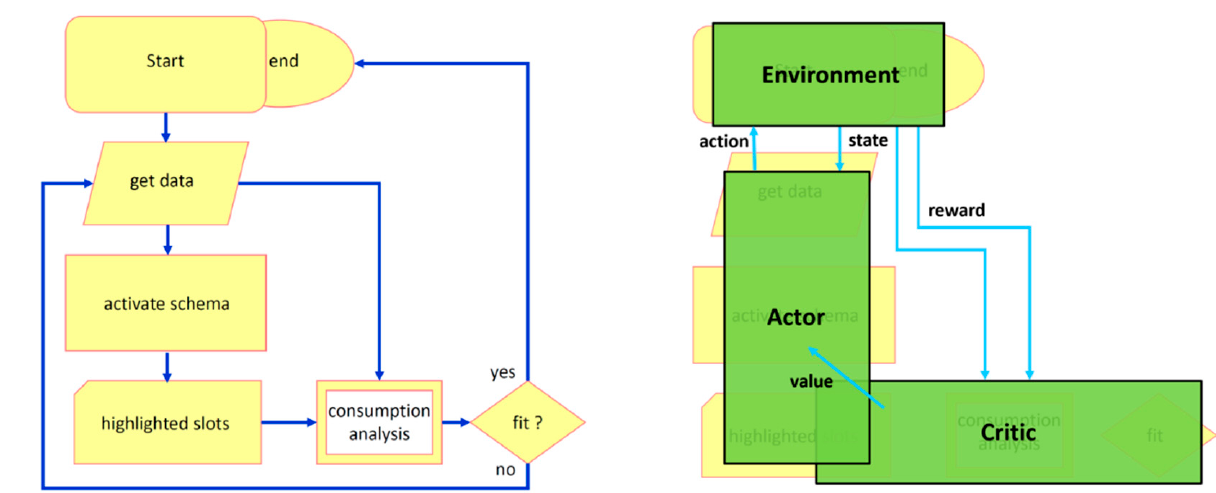
Figure 1. Coarse correspondence between the Ouroboros Model and a generic actor-critic neural network; ( left ): most simple version Ouroboros Model with arrows indicating the procedural flow [1], ( right ): generic actor-critic block diagram as an overlay .